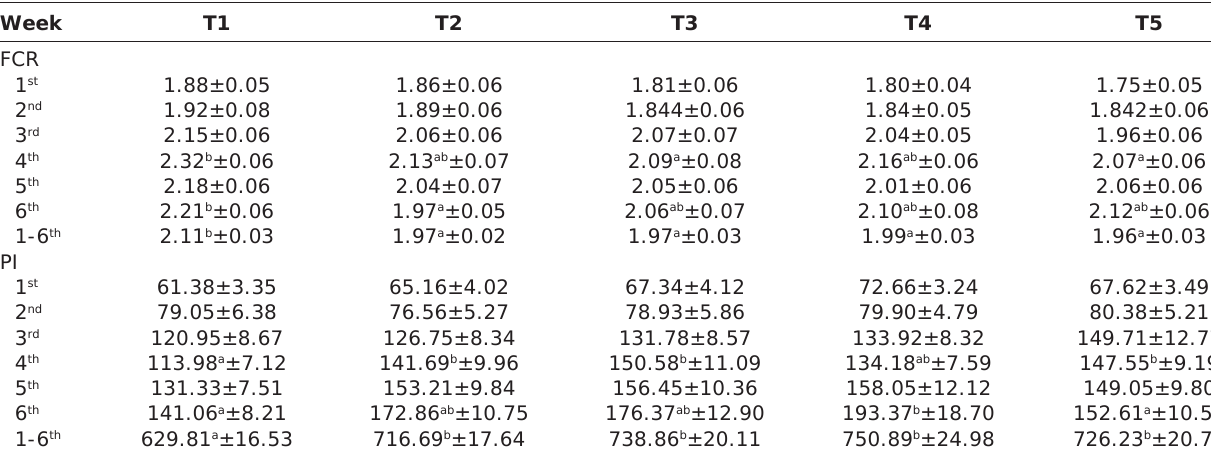
Table-6: Effect of dietary supplement of herbs/spices on FCR and PI at weekly interval and 6 th week in broilers. Week